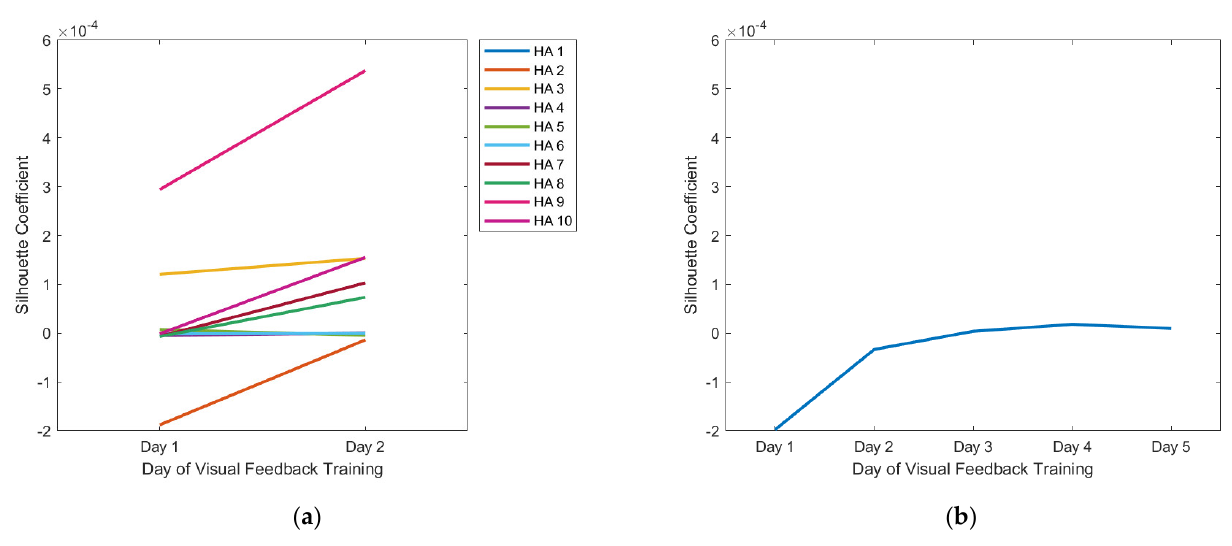
Figure 8. SC quantification of variability in the sEMG signals: ( a ) healthy adults, ( b ) forearm amputee.